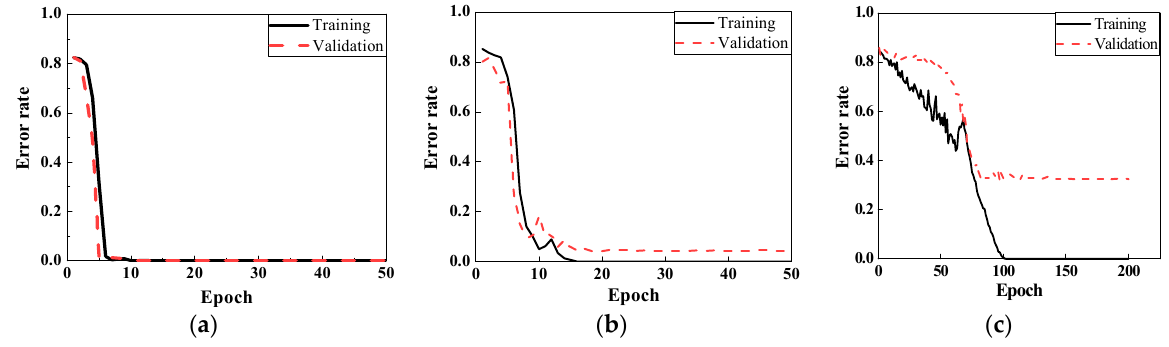
Figure 19. Training and validation results. ( a ) SNR = 80 dB; ( b ) SNR = 70 dB; ( c ) SNR = 60 dB.